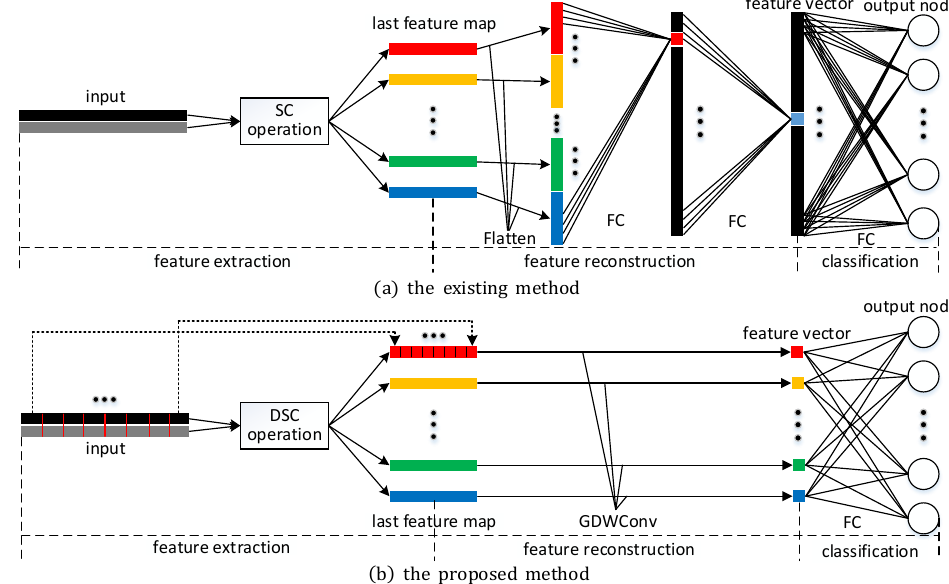
Figure 1. The overall structure of CNN-based method. We divide the structure into three parts: feature extraction, feature reconstruction and classification. ( a ) The existing methods perform SC operation in the feature extraction part, and FC layers are adopted in feature reconstruction part; ( b ) the proposed method performs DSC operation in the feature extraction part, and GDWConv is adopted in feature reconstruction